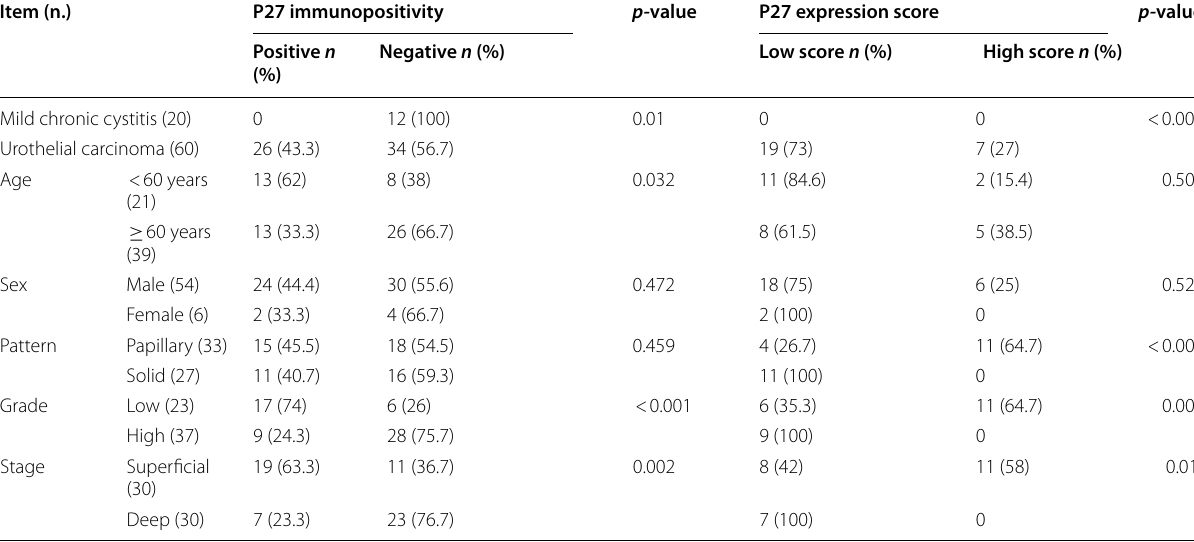
NMIBC Non-muscle invasive bladder cancer, MIBC Muscle-invasive bladder cancer, n Number, % Percentage Table 3 Pattern of survivin and p27 staining in urothelial carcinomas